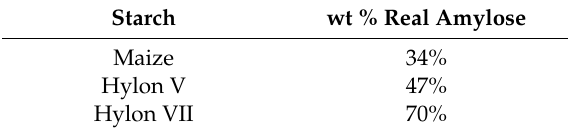
Table 2. Nanoporosity data of the prepared mesoporous carbons at 800 °C. Precursor